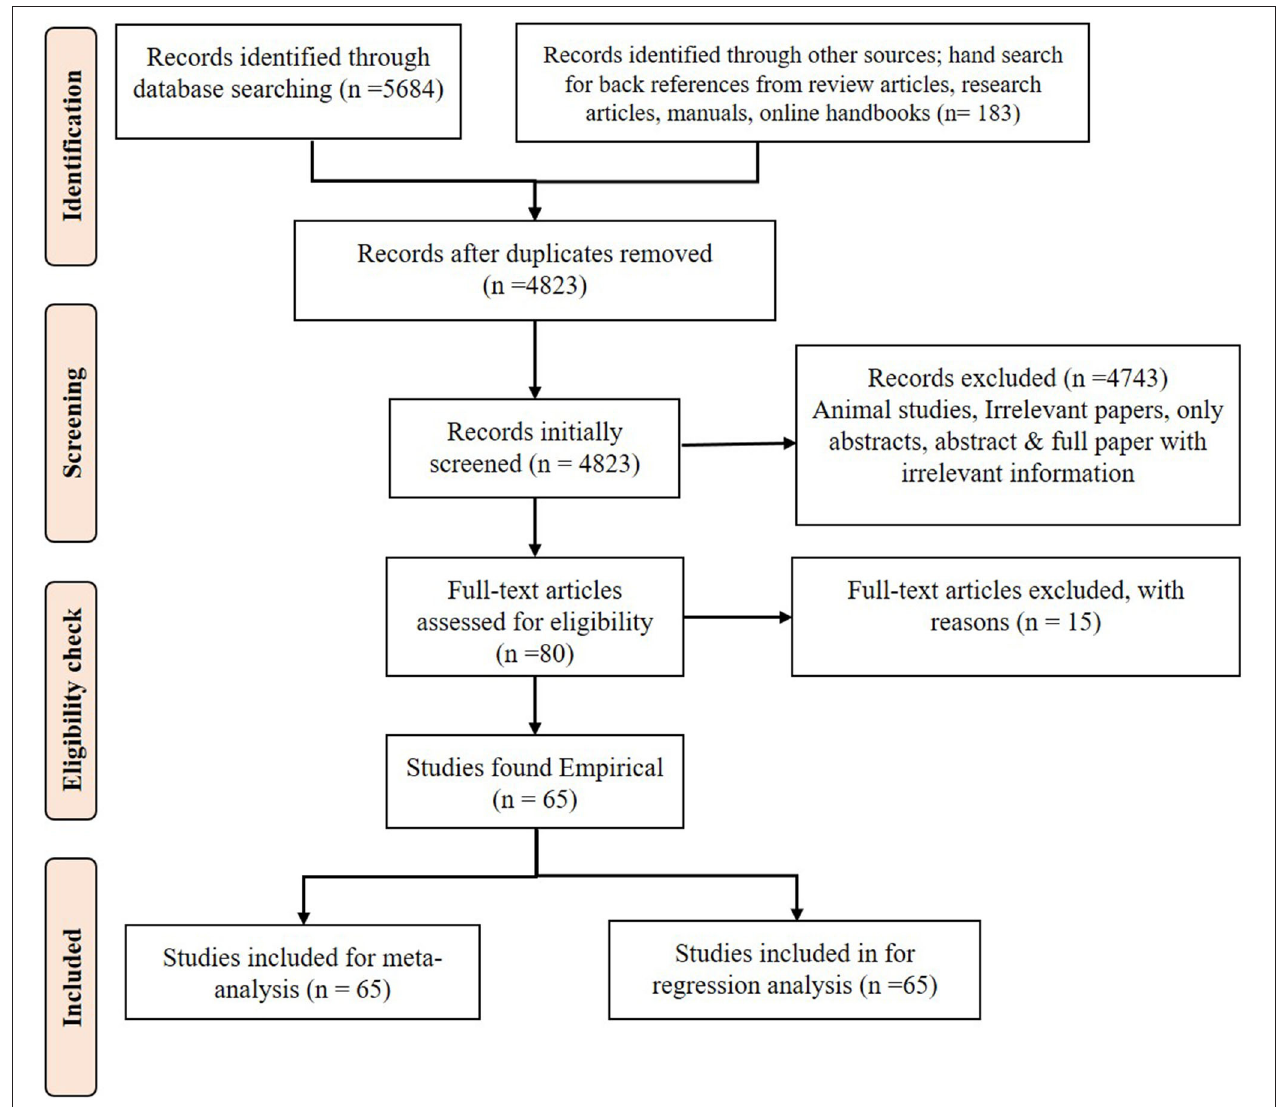
FIGURE 1 | A PRISMA flow diagram of the systematic